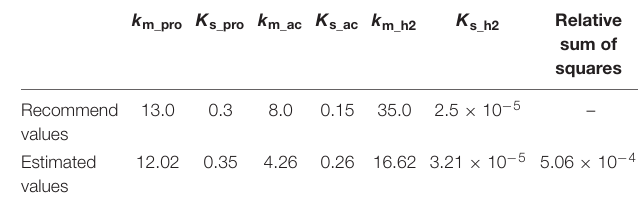
TABLE 2 | Parameter estimation result of the model.